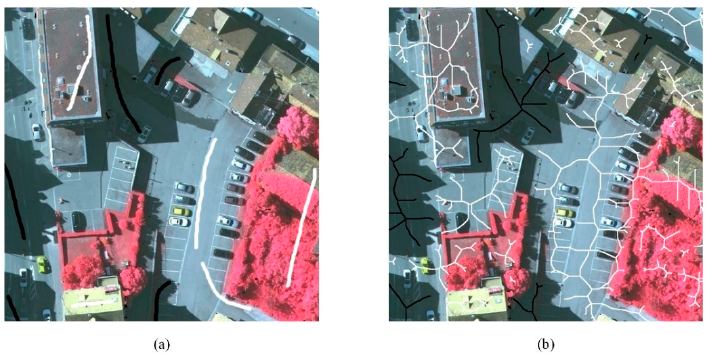
Figure 7. Shadow delineation: ( a ) manually delineated; and ( b ) automatically generated by the proposed method. The black/white lines mark the shadowed/non-shadowed areas.